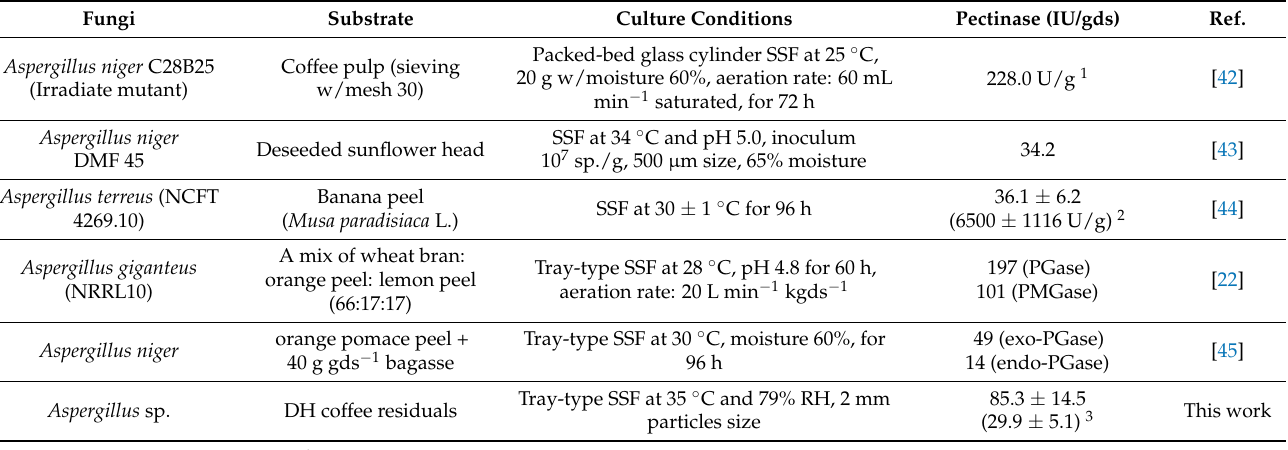
Table 5. Some SSF processes leading to pectinase production by Aspergillus spp. and their characteristics.